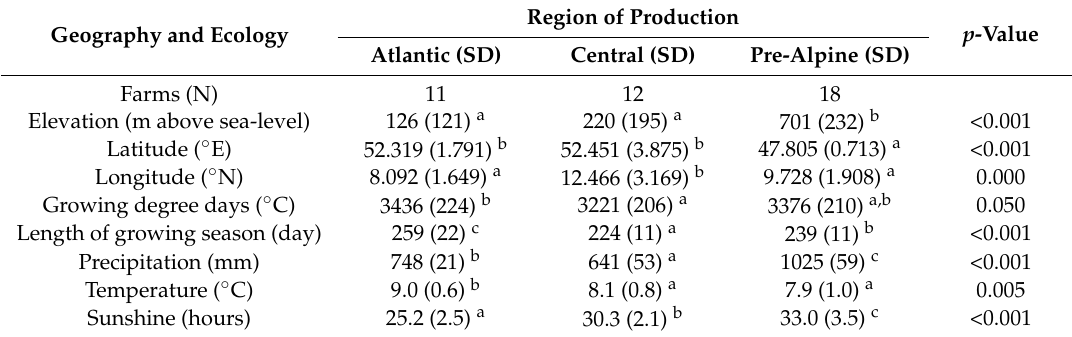
Table 2. Geography and climatological values of the three regions of production; mean values per year and standard deviation (SD), based on the strata outlined in Reference